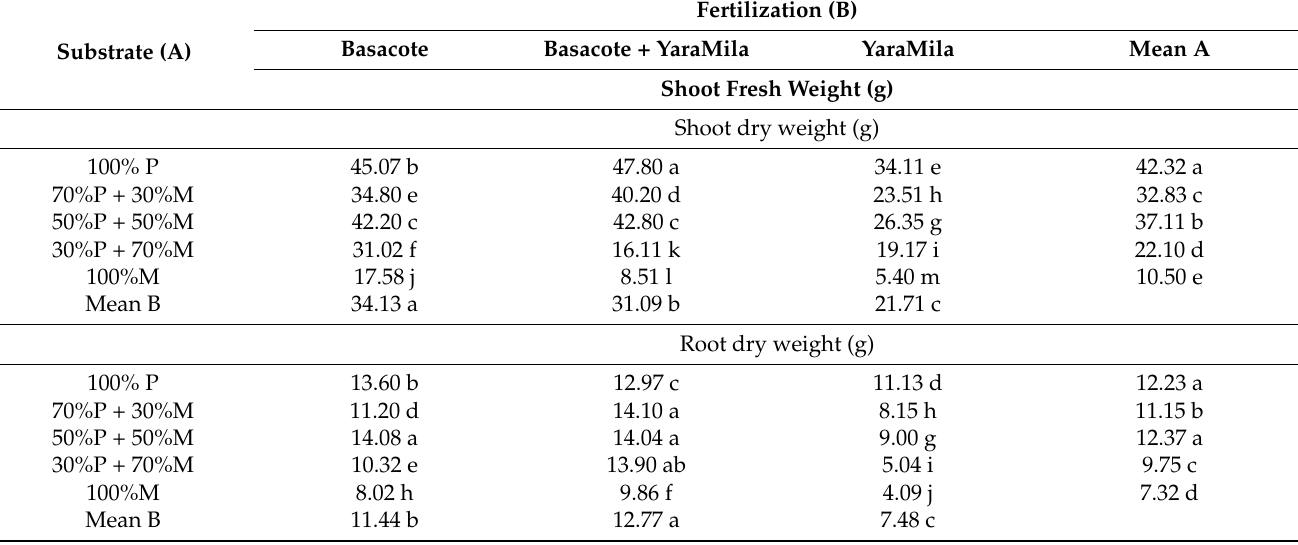
Table 7. Fresh and dry weight of Hydrangea arborescence ‘Annabelle’ grown in containers with five different